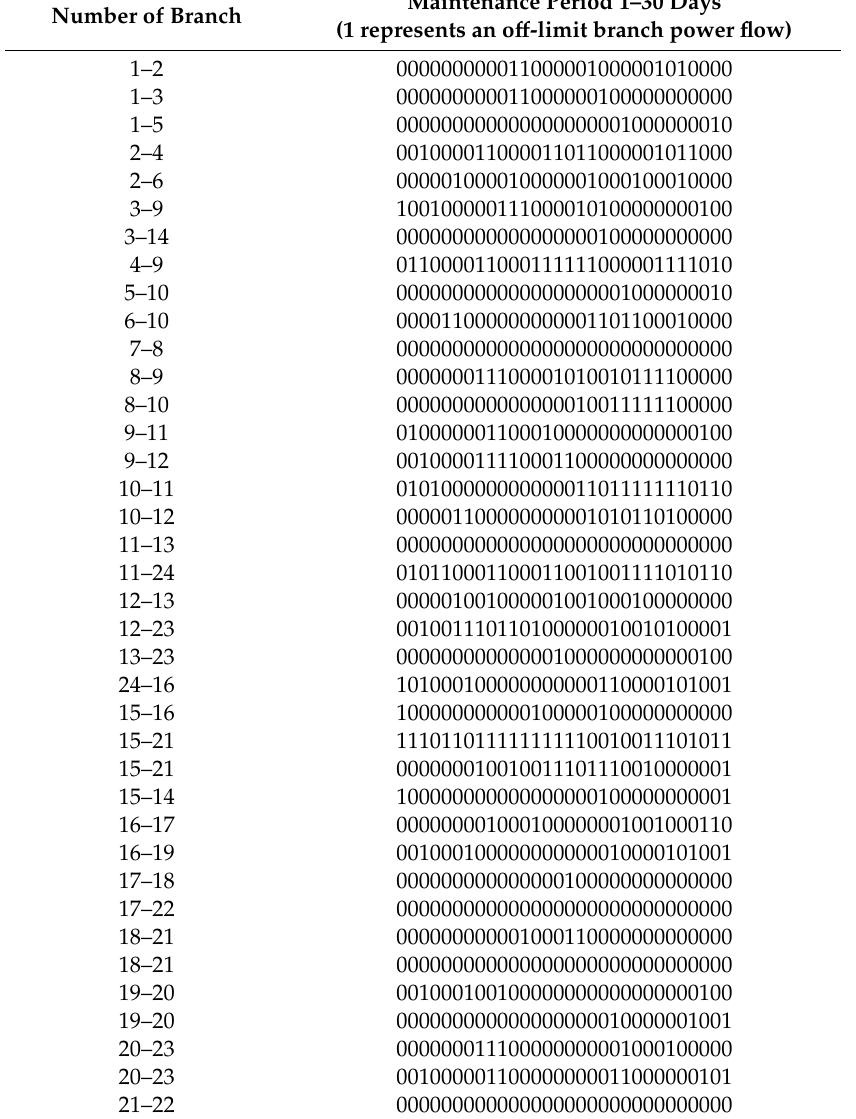
Table A6. Solution A o ff -limit branch power